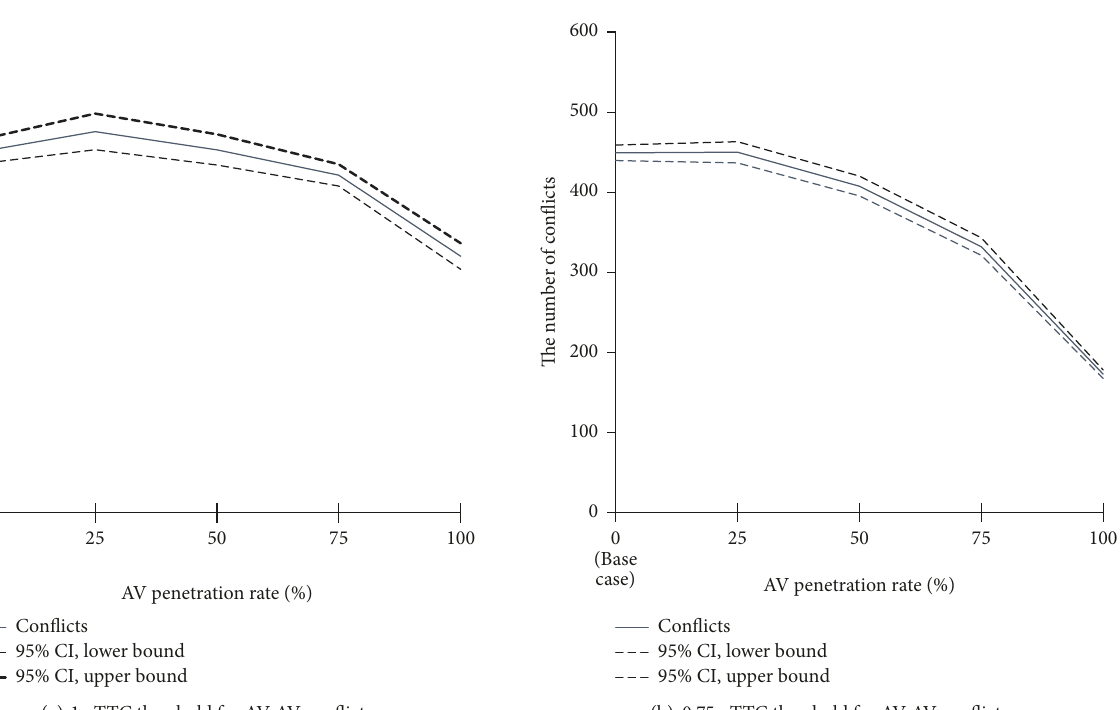
Figure 7: Total number of conflicts by AV penetration rate for the roundabout (AV-1 parameters).